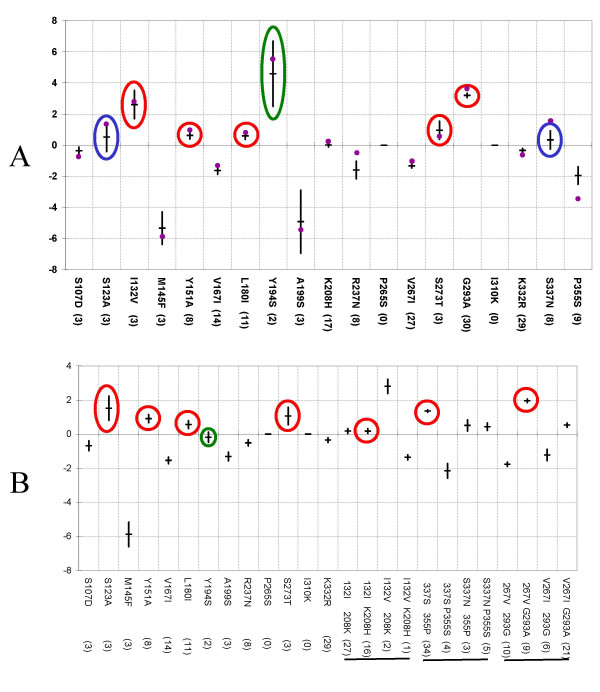
Substitution weight mean and standard deviation values produced by the MR algorithm. We created 1000 subsamples of the training set (the sequences and non-zero activities of variants from sets 1 and 2) by leaving out 5 randomly selected variants from each subsample. A: The MR (matching loss) algorithm was used to calculate substitution weights for each subsample. The mean values from the 1000 subsamples are indicated by horizontal notches. Error bars represent one standard deviation of the 1000 calculated substitution weights. Substitutions are indicated below the graph with the number of occurrences in the training set in parentheses. Each substitution is described by a single weight. Variant 3–4 was designed to include all substitutions with positive mean weight that occur at least 3 times in the training set (red and blue circles). Note that substitution Y194S (green circle) was not selected since it occurred less than 3 times in the training set. Variant 3–9 included all substitutions that occurred at least 3 times and whose mean weight was at least one standard deviation above zero (red circles only). Substitution weights calculated from the entire dataset instead of the mean of 1000 subsamples are shown as purple circles. B: The MR algorithm was used to calculate substitution weights as in A, except that models were tested by expanding each pair in turn into 4 terms and selecting the pair that most improved the model. In this example each substitution is described by a single weight except for the 3 pairs (132,208), (337,355), (267,293) which are modeled by 4 weights each. Re d circles indicate the substitutions selected to design variant 3–14. Note that substitution combination I132V 208K was not selected since it occurred less than 3 times in the training set.